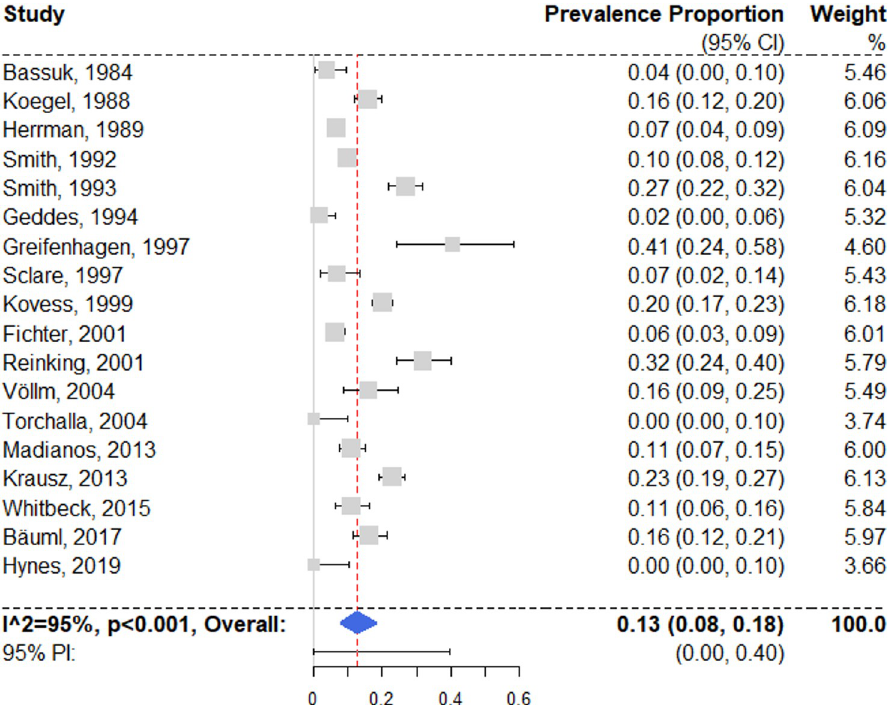
Fig 4. Forest plot of prevalence estimates of major depression. AU : Basedonthereferenceslist ; IbelievethefollowingareerrorsinFig 4 : ð 1 Þ Newton ; 1994 shouldbeGeddes ; 1994 ½ 67 �ð 2 Þ Hynes ; 2018 shouldbeHynes ; 2019 ½ 62 � PleasefixtheseerrorsinFig 4 : Asecond (cid:0) bestsolutionwouldbetoequatethesemisidentifiedrefswiththeircorrectreferencenumbersinthefigurelegend : Analytic weights are from random effects meta- analysis. Grey boxes represent study estimates; their size is proportional to the respective analytical weight. Lines through the boxes represent the 95% CIs around the study estimates. The blue diamond represents the mean estimate and its 95% CI. The vertical red dashed line indicates the mean estimate. CI, confidence interval; PI, prediction interval; RE, random